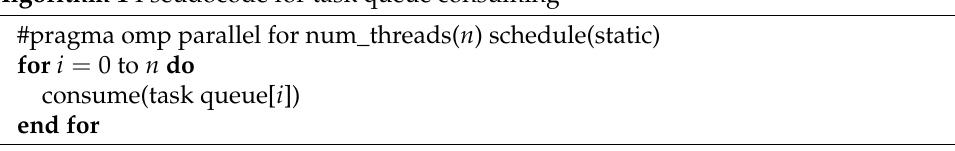
Algorithm 1 Pseudocode for task queue consuming